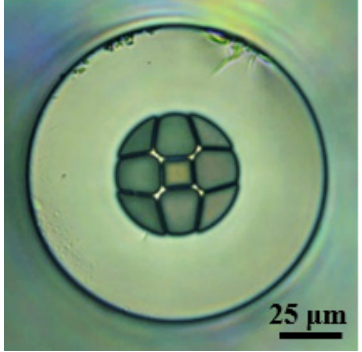
Figure 2. Microscopic picture of the HSCF cross section.